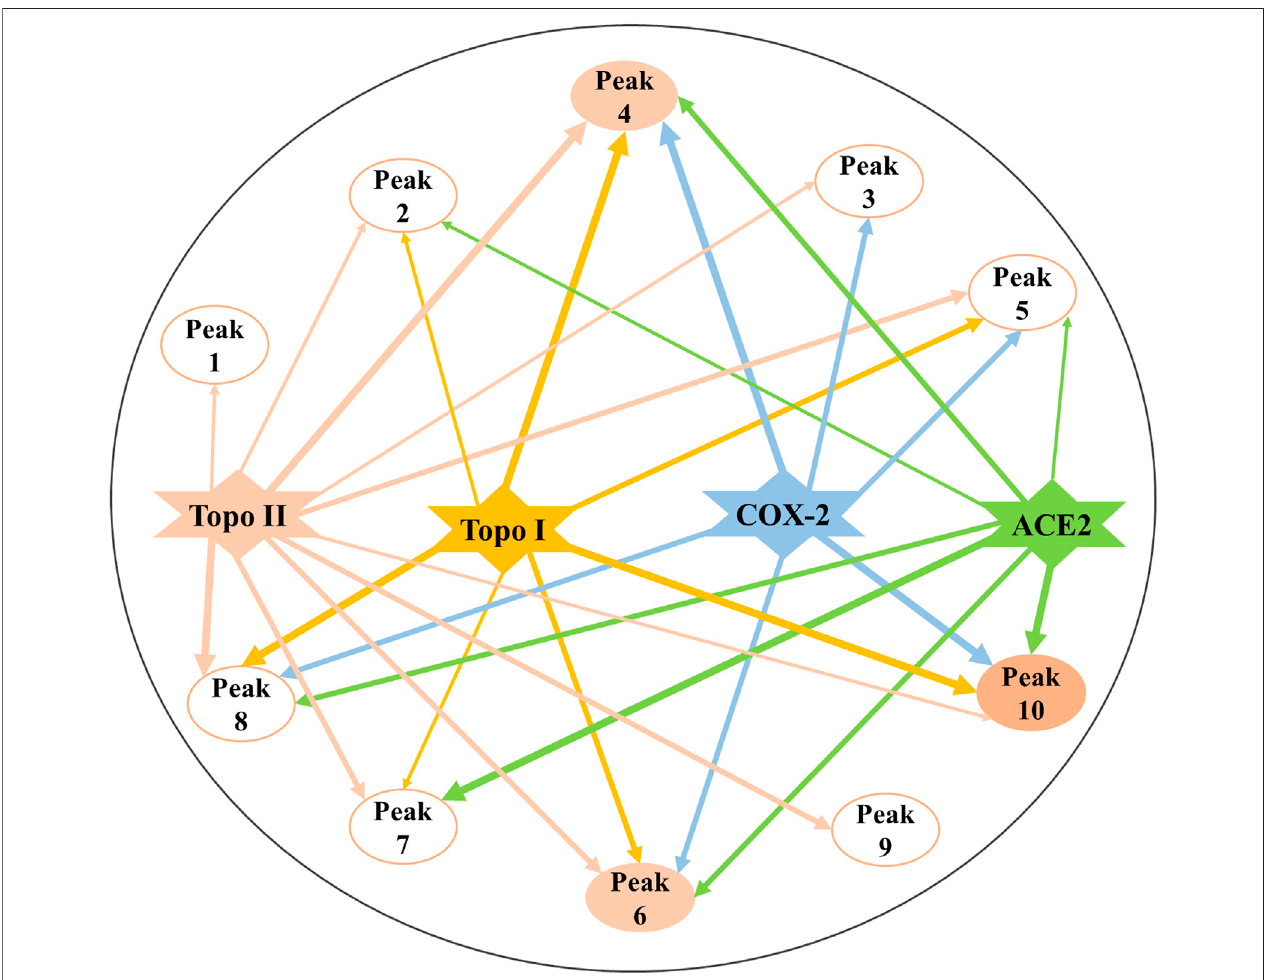
FIGURE7| Constructedmulti-componentandmulti-targetnetworkincorporatingthepotentialbioactivecomponentsscreenedoutwithmultipledrugtargets.The line thicknesses roughly represent the binding or action intensity for their corresponding interactions.